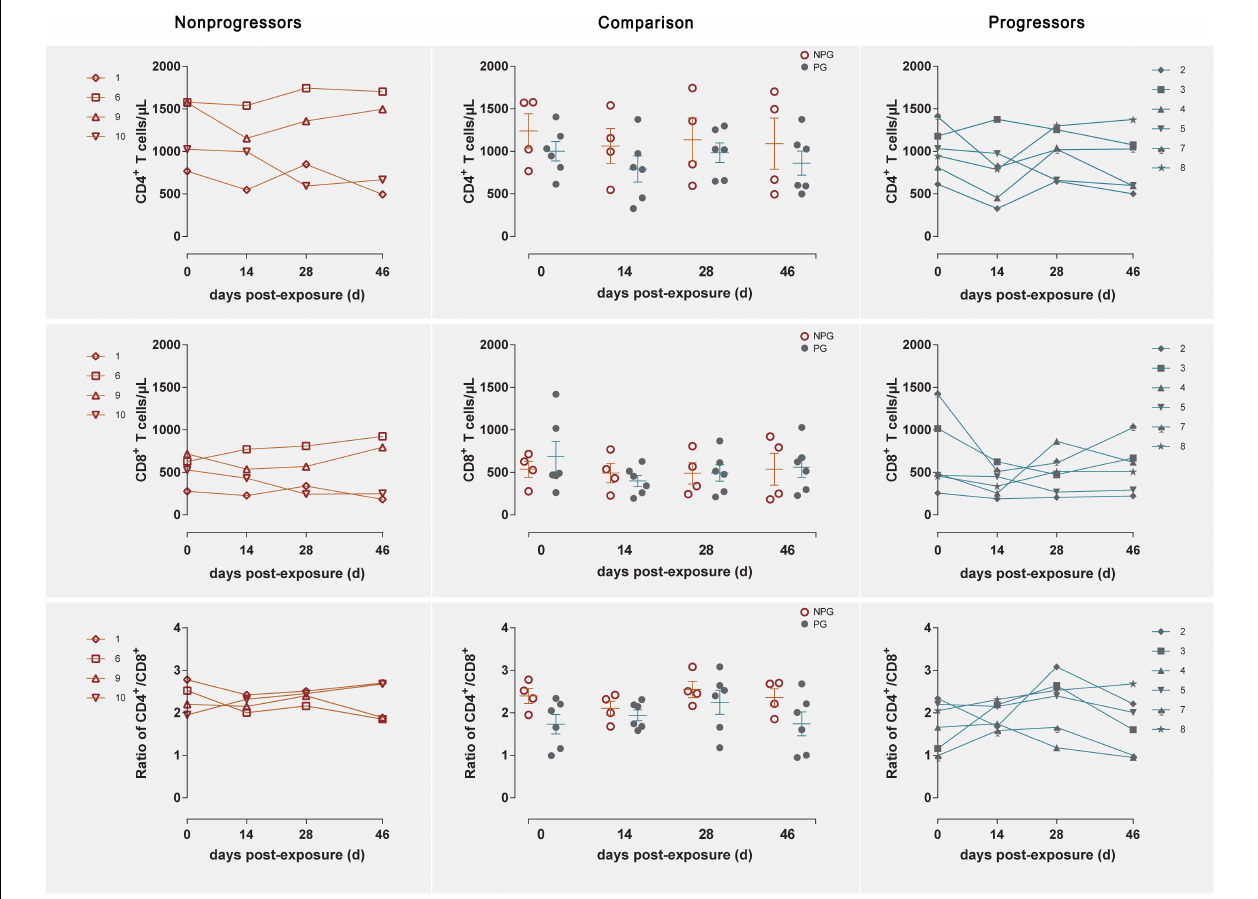
FIGURE 3 | Changes in T lymphocytes among PBMCs between non-progressive and progressive monkeys. The CD4 + T cell counts, CD8 + T cell counts, and CD4 + /CD8 + ratios were measured in peripheral blood at four time points in four non-progressive monkeys and six progressive monkeys. No significant differences were found between the two subgroups at any time point, indicating that no notable T cell changes occurred in PBMCs from ChRhs subjected to repetitive SIV mucosal exposure (unpaired t -test, Welch’s correction, P > 0.05).